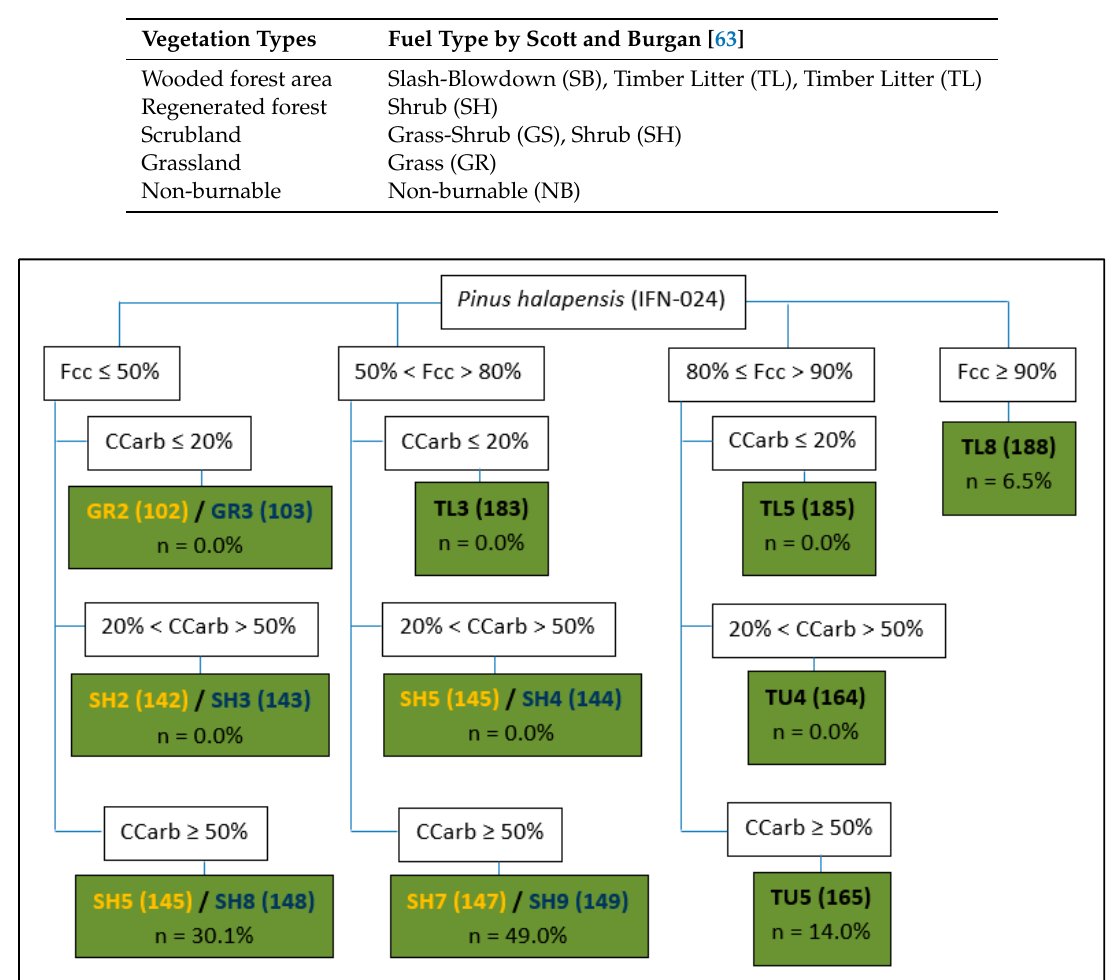
Figure 3. Algorithm used for assignation of the Scott and Burgan [62] model to stand populated by Pinus halepensis ; Fcc = Forest Canopy Cover; CCarb = Understory Shrub Cover; yellow color = model assigned if the pixel is located within the dry area; blue color = model assigned if the pixel is located within the humid area; black color = model assigned regardless of the area; n = representativeness of the model (% in the total area covered by species).